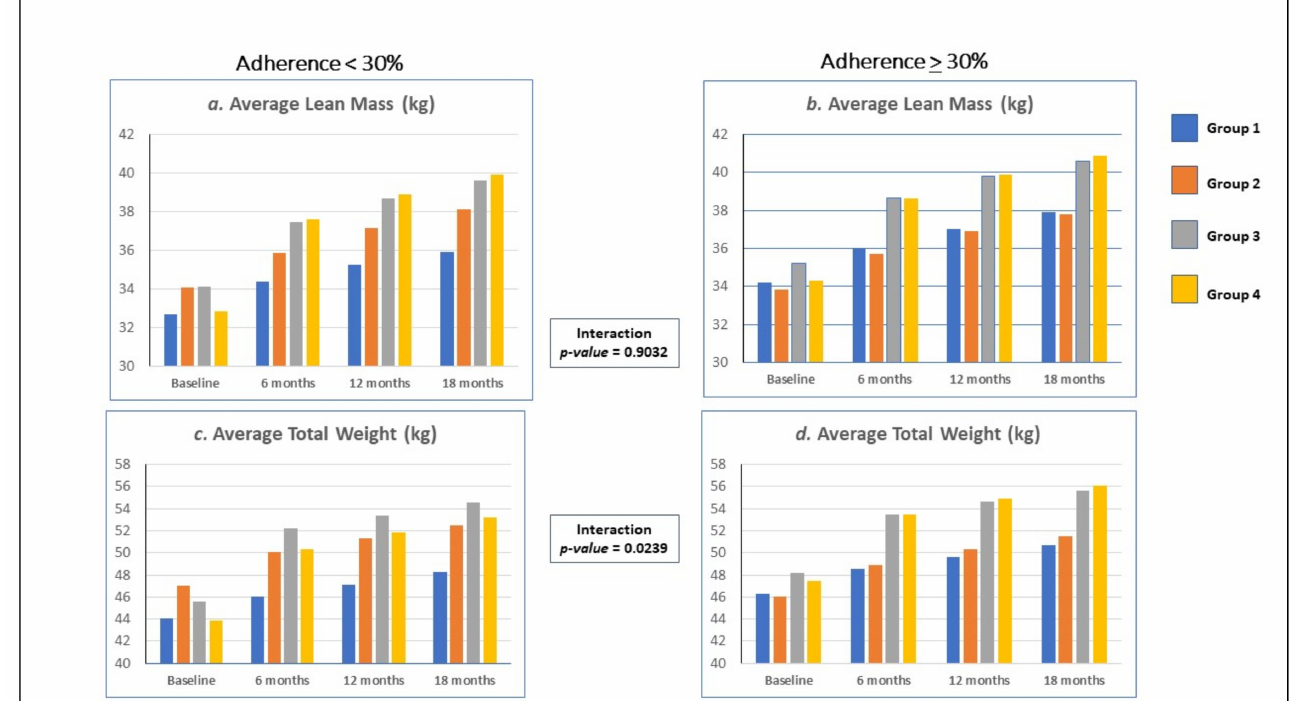
Figure 2. Group by Time Means of Lean Mass and Total Weight by Adherence. ( a ) Adherence < 30%, Lean Mass by Group by Time; ( b ) Adherence > 30%, Lean Mass by Group by Time; ( c ) Adherence < 30%, Total Weight by Group by Time; ( d ) Adherence > 30%, Total Weight by Group by